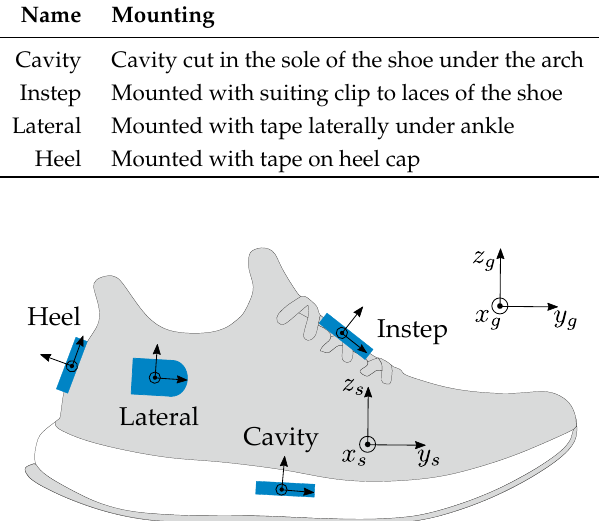
Figure 3. Visualization of sensor positions on the running shoes, the global coordinate system ( x g , y g , z g ) , the shoe coordinate system ( x s , y s , z s ) , and the individual sensor coordinate systems. When the foot is flat on the ground, the global and the shoe coordinate system are